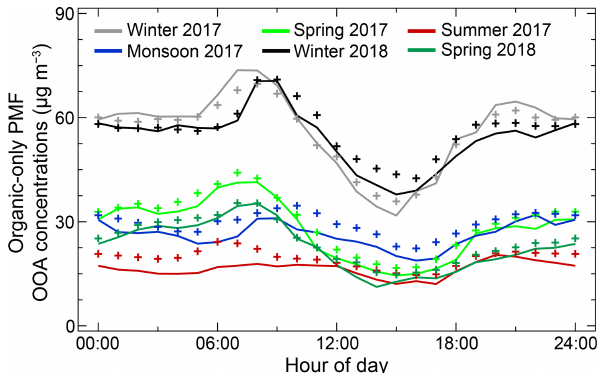
Figure 4. Seasonally representative diurnal mean ( + ) and median concentrations (lines) of OOA from organic-only PMF analysis. This figure shows the higher concentrations of OOA in winters com- pared to other months and the relatively stronger diurnal variations in winters and springs compared to other